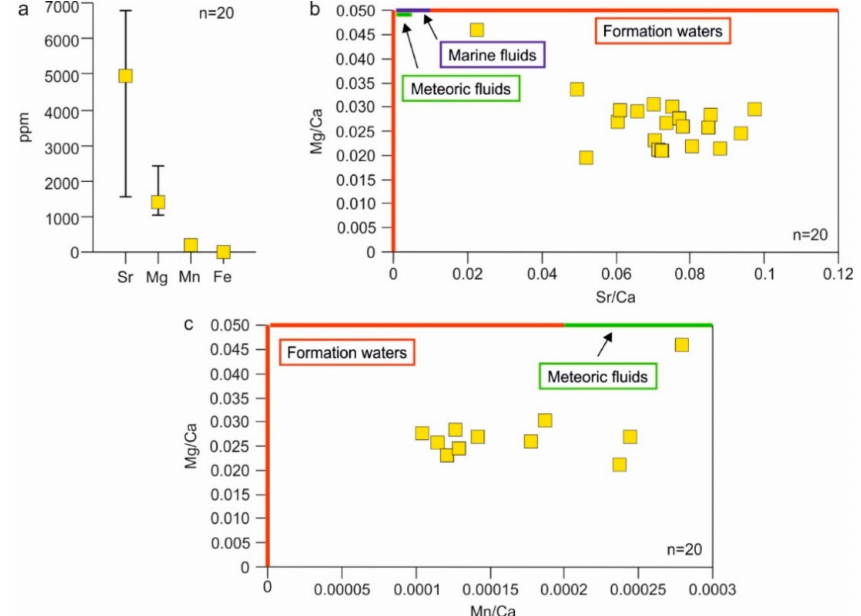
Figure 11. ( a ) Mg, Sr, Fe, and Mn content of bladed calcite crystals. Maximum, minimum, and mean values are given. ( b , c ) Mg / Ca vs. Sr / Ca and Mg / Ca vs. Mn / Ca cross-plots of bladed calcites. Areas bounded by blue, green, and red thick lines represent the composition of marine, meteoric, and formation fluids, respectively, based on References